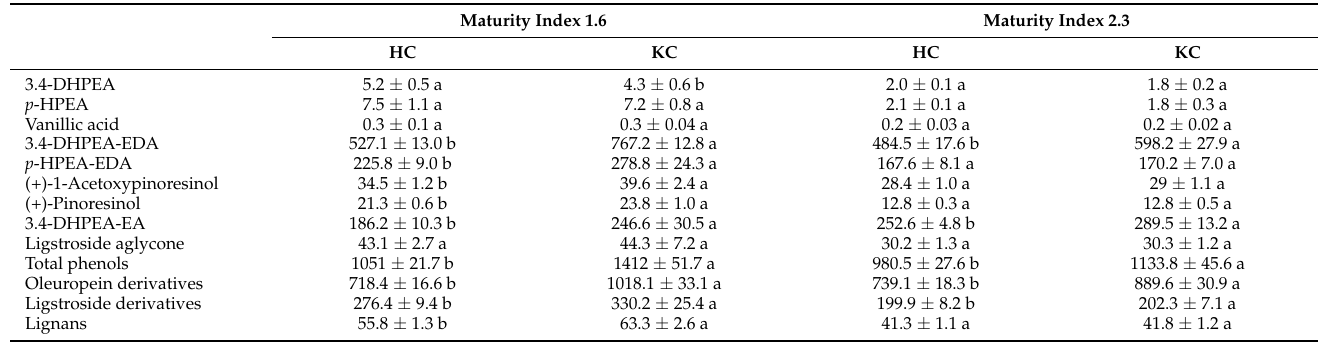
Table 6. Phenolic composition of EVOOs. Data expressed as mg kg − 1 *.